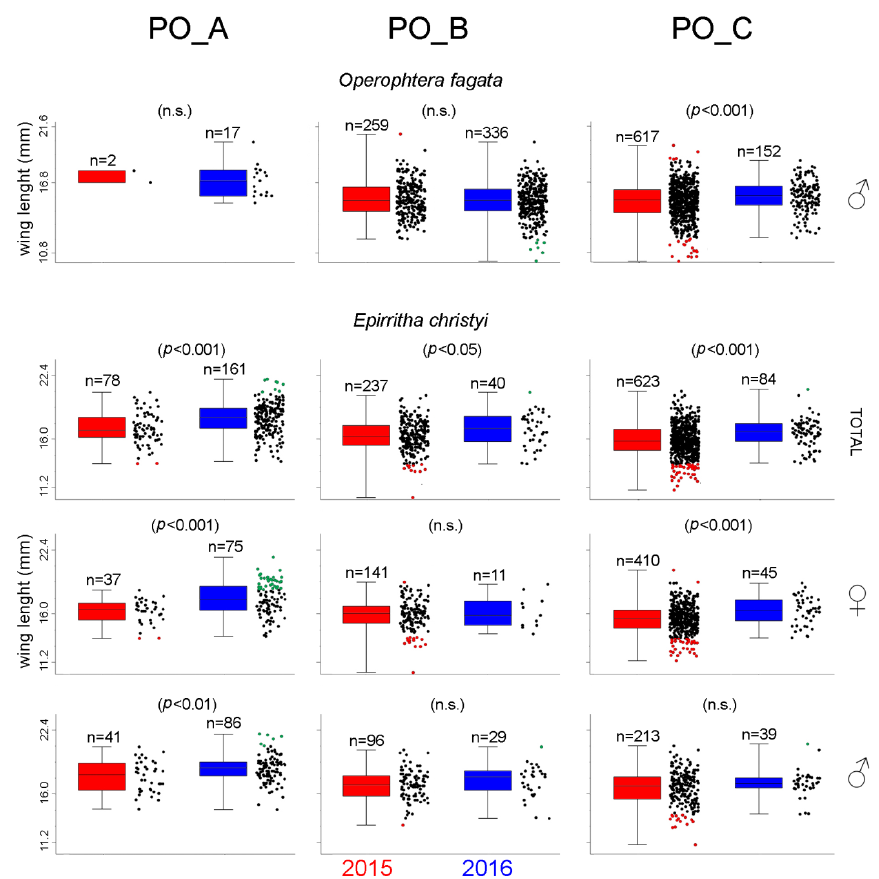
Figure 6. Box and Jitter plots for wing measurements (distance between the insertion point and apex of the forewings) of Operophtera fagata and Epirrita christyi . Red dots of Jitter plots indicate 2015 measurements that exceeded the 2016 range, and green dots indicate 2016 measurements that exceeded the 2015 range. For each sampling site is given the numbers of measured specimens (n), differences between years were evaluated using the t -test and p -level reported in parentheses; n.s. means not significant.